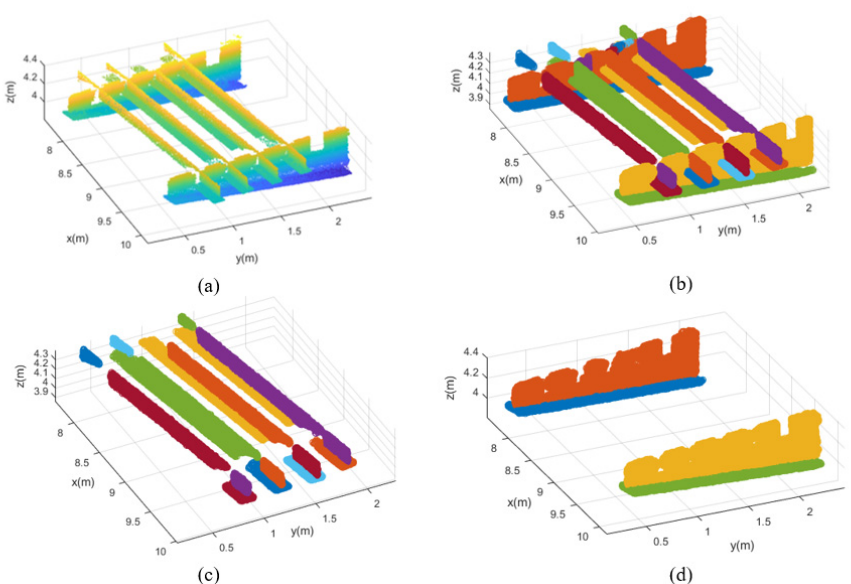
Figure 5. Recognition of T ribs: ( a ) extraction of the scanned data related to T ribs through subtraction algorithm; ( b ) robust cluster-growing outcome; ( c ) I beams with different attribute labels; and ( d ) T ribs with occlusion noise.